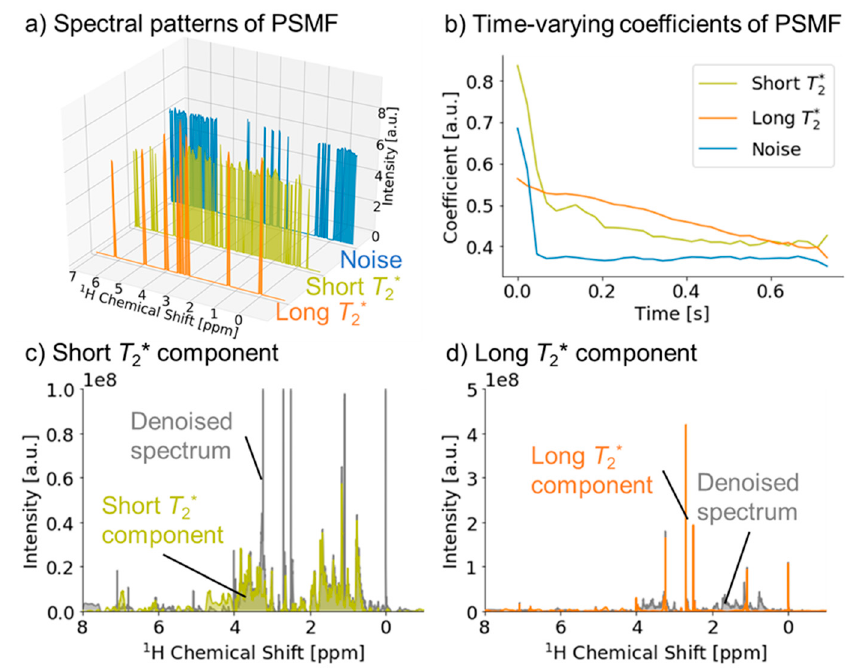
Figure 4. Application of the signal deconvolution method to diffusion-edited spectra. ( a ) Spectral patterns showing signals from small molecules (orange) and macromolecules (olive) separated by the length of the T 2 * relaxation time, and noise (blue). ( b ) Time-varying coefficients of each component in MF. ( c ) Denoised spectrum (gray), and spectrum of the short T 2 * component (olive). ( d ) Denoised spectrum (gray), and spectrum of the long T 2 * component (orange).